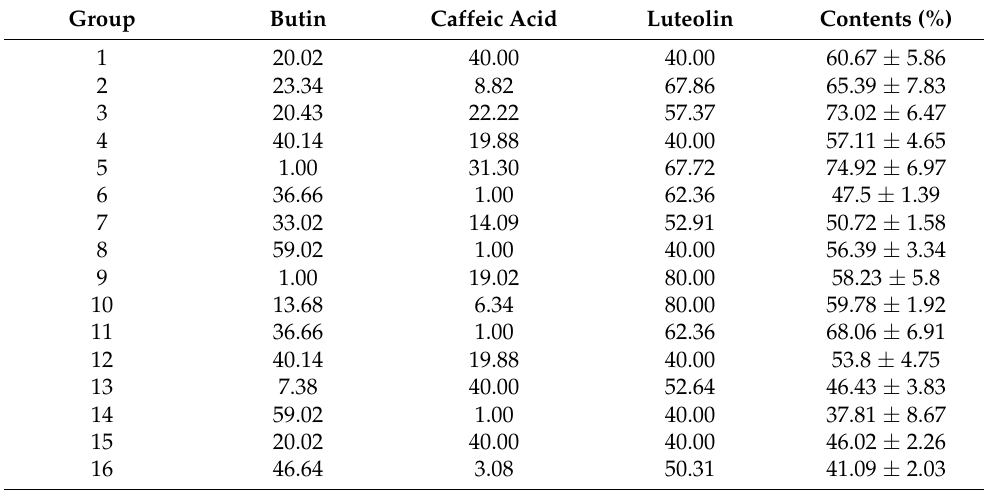
Table 1. The Contents are the relative of melanin contents (% of control group), and the combinations are concentrations ( µ mol/L) of the three compounds. Combinations in D-optimal Design and their relative of melanin contents (% of control) mean ±